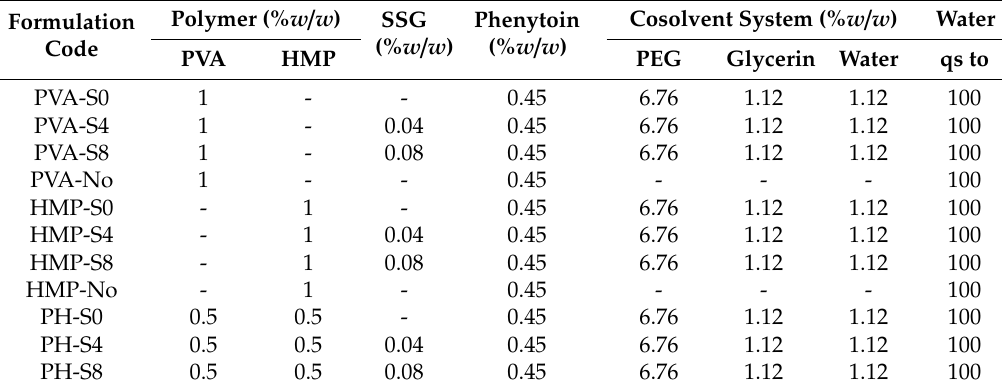
Table 1. Composition of di ff erent film casting